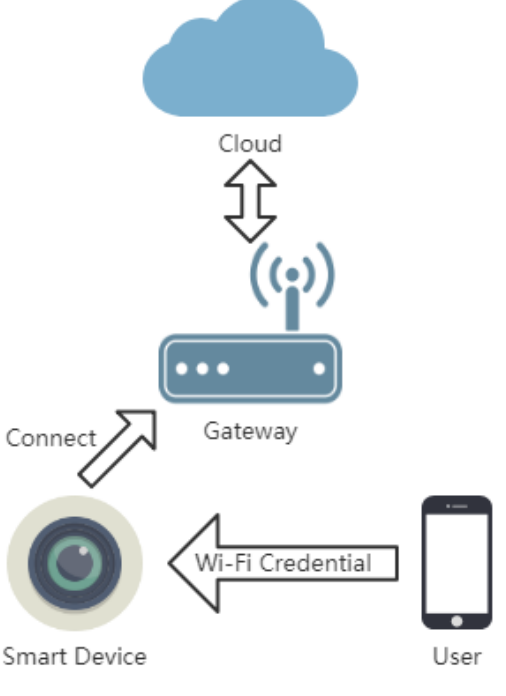
Figure 1. Device–gateway–cloud scheme in smart home. Users need to tell their devices the Wi-Fi credentials so that the smart devices can communicate with cloud bypassing